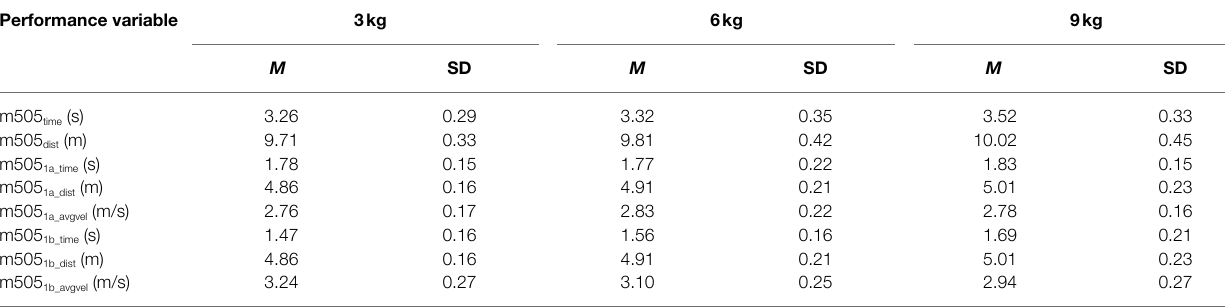
TABLE 1 | m505 test results for the different loaded conditions. Performance